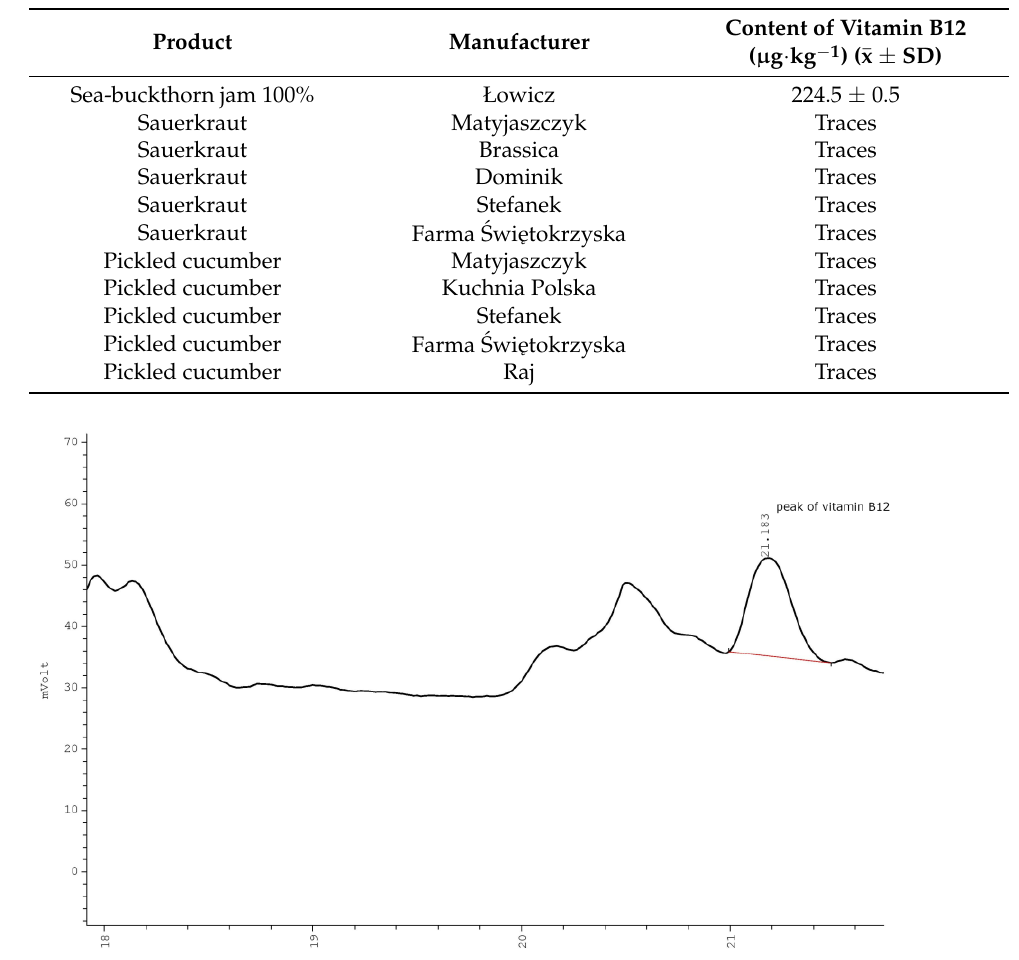
Figure 1. Calibration curve of cyanocobalamin. Table 1. Content of cyanocobalamin in solid samples of fermented vegetable products.